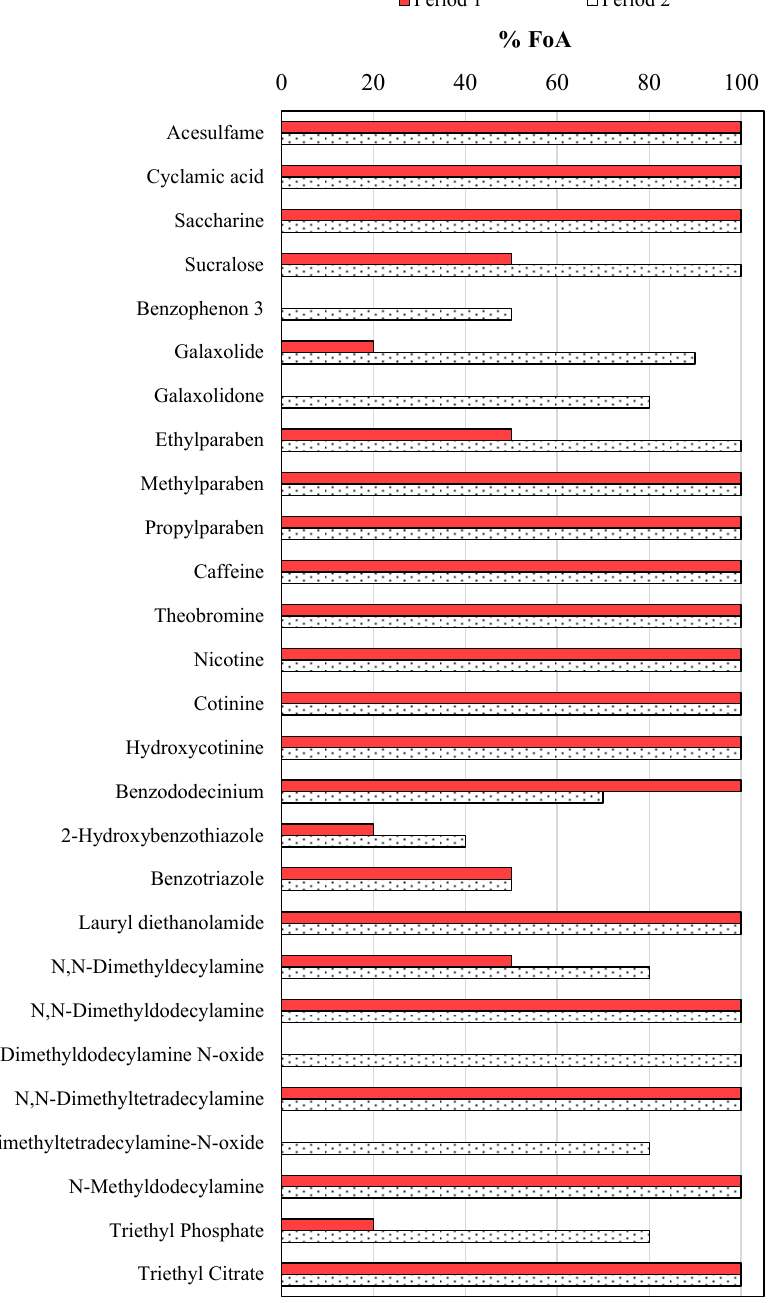
Figure 1. Frequency of appearance (FoA%) of detected emerging contaminants in HWW for Period 1 and 2. The average concentrations of measured substances, along with the minimum and maximum values for all monitored sites and periods, are presented in Table 2.